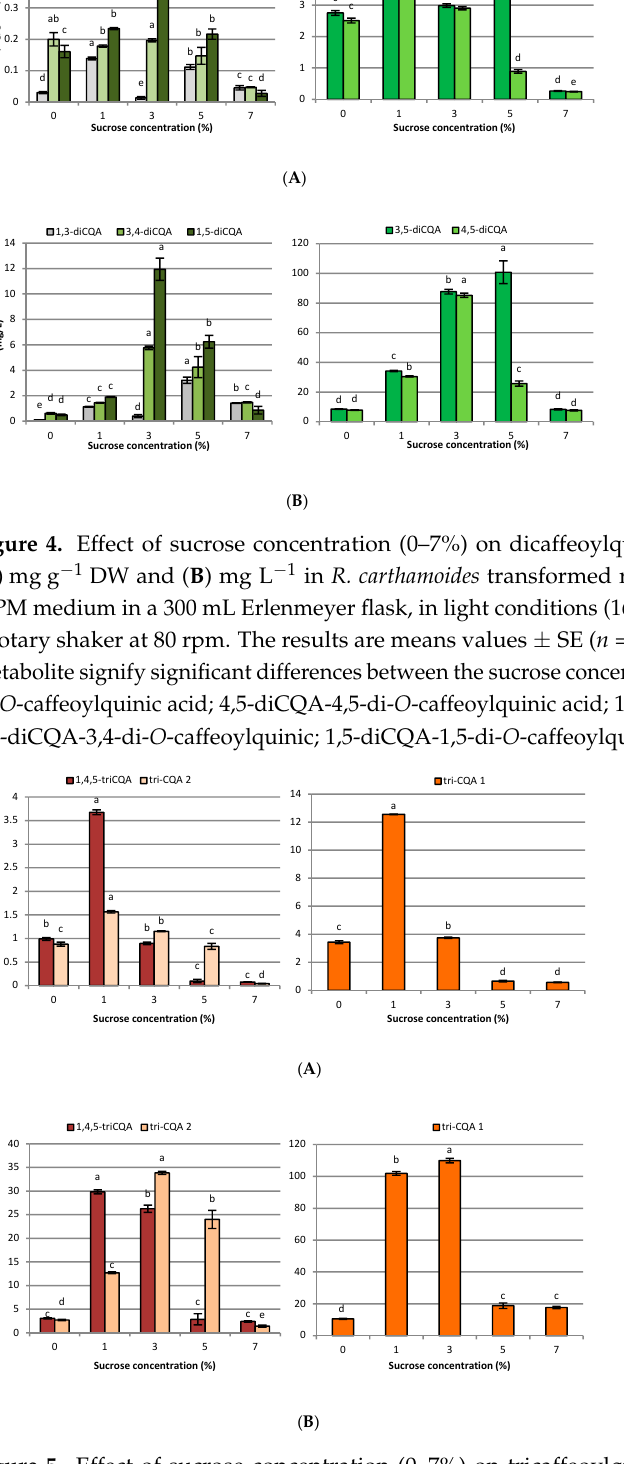
Figure 5. Effect of sucrose concentration (0–7%) on tricaffeoylquinic acid derivative contents in ( A ) mg g − 1 DW and ( B ) mg L − 1 in R. carthamoides transformed roots cultured in 50 mL of liquid WPM medium in a 300 mL Erlenmeyer flask, in light conditions (16/8-h light/dark photoperiod) on a rotary shaker at 80 rpm. The results are means values ± SE ( n = 9). Different letters for the same metabolite signify significant differences between the sucrose concentrations ( p < 0.05). 1,4,5-triCQA- 1,4,5-tri- O -caffeoylquinic acid; tri-CQA 1 and tri-CQA 2-tricaffeoylquinic acid derivatives.